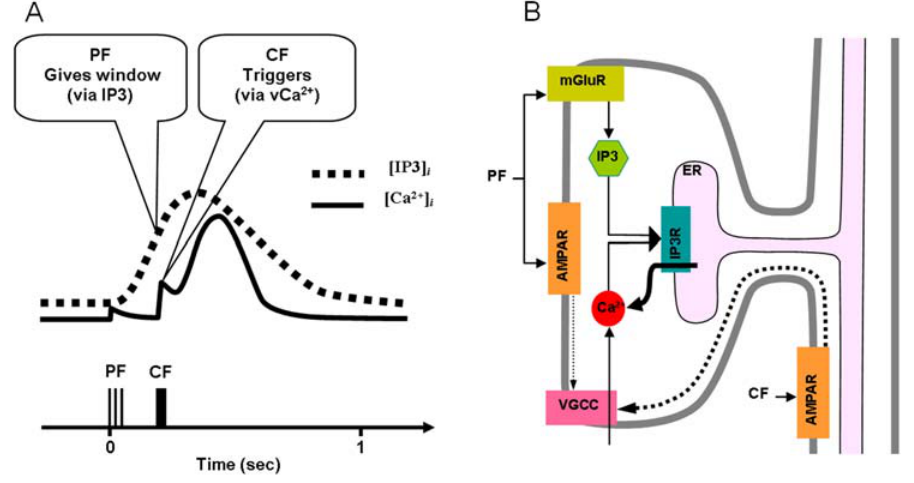
Figure 6. The simplified scheme for slow-rising calcium activation used in the simulation. A. Illustration of conclusion by Doi et al.[39]. PF generates IP3 activation profile (dotted curve), which gives the same window for regenerative Ca 2 + activation irrespective of CF signal. CF signal triggers the regenerative Ca 2 + activation (the round big hump, later part of solid trace) by mobilizing voltage-gated calcium (vCa 2 + ) influx via voltage- gated calcium channels (VGCCs). The lower part of the figure shows the PF, CF signals. B. The circuit used by the current model. The figure shows signal pathways recruited by PF and CF. The big arrowhead with two stems indicates a multiplicative process that realizes the cooperative actions by IP3 and vCa 2 + explained in panel A. Only the excitatory interactions (arrows) are shown for clarity. The thick black arrow indicates the calcium release from the endoplasmic reticulum (ER). See text for details. IP3R: IP3 receptor.